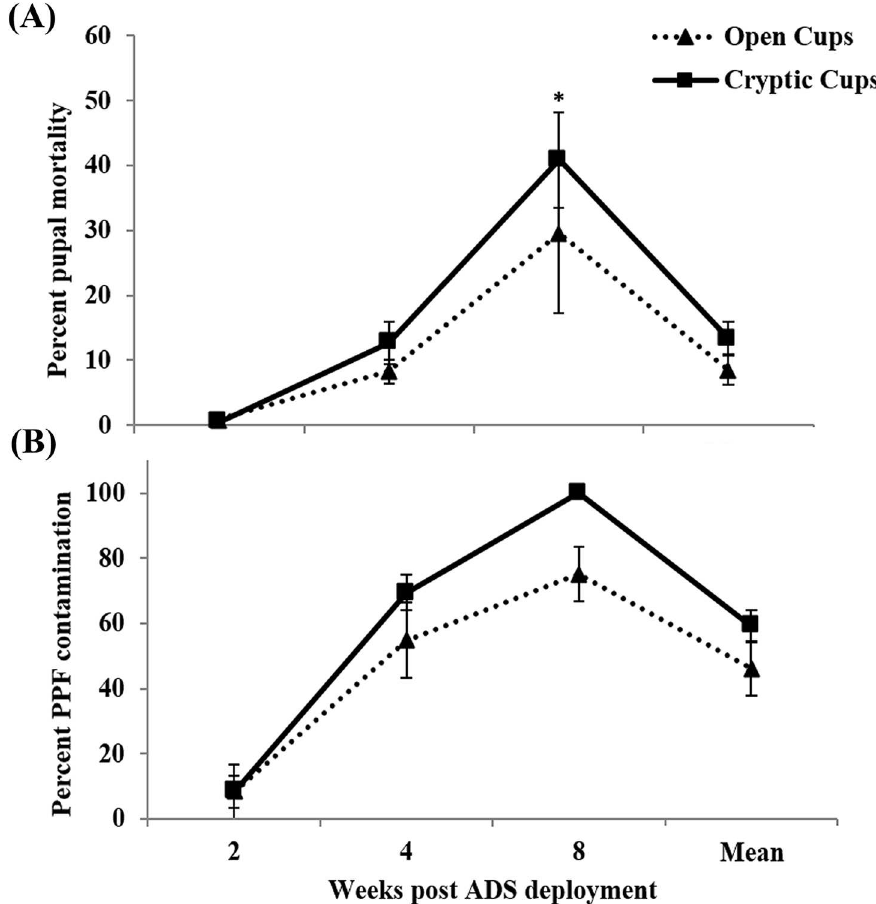
Fig 4. Weekly percent pupal mortality (A) and pyriproxyfen contamination (B) in open and cryptic cups during 2013 field experiment. Significantdifference indicatedby * ( p < 0.05).Data are shown as mean ±